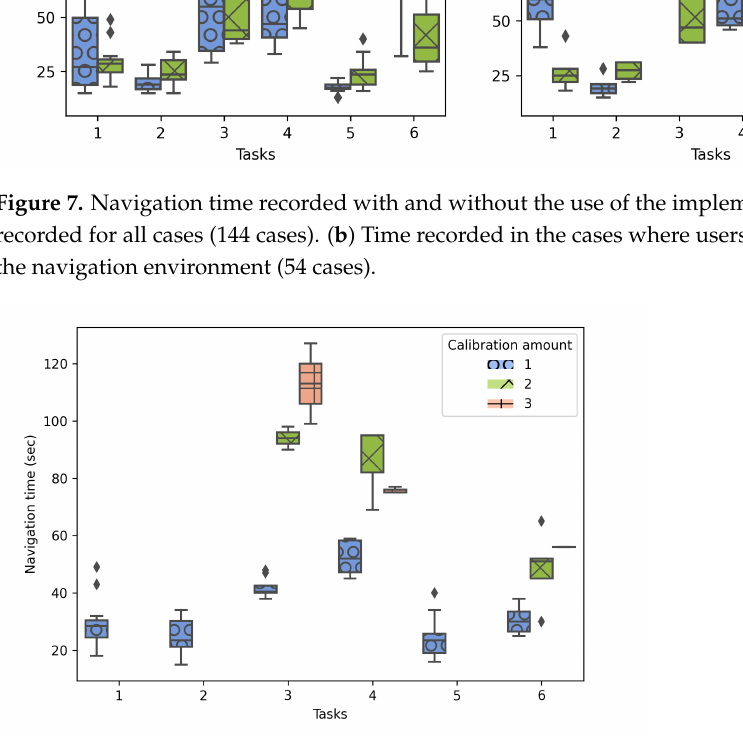
Figure 8. Recorded navigation time considering the amount of